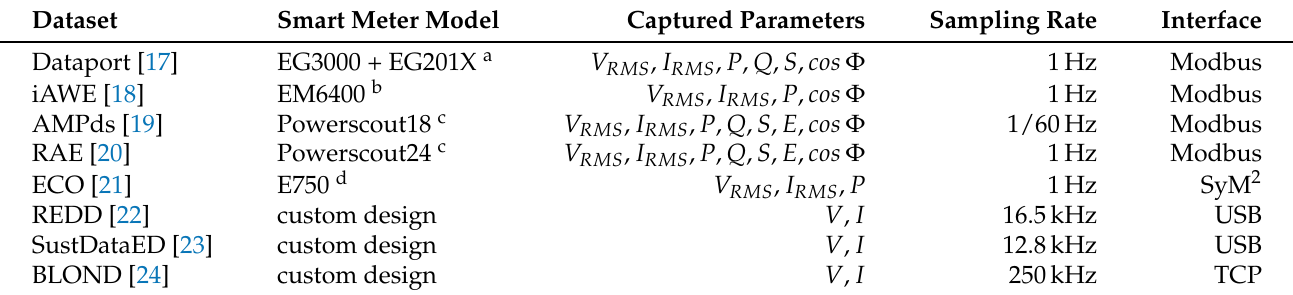
Table 1. Metering devices used and parameters provided in a selection of electricity